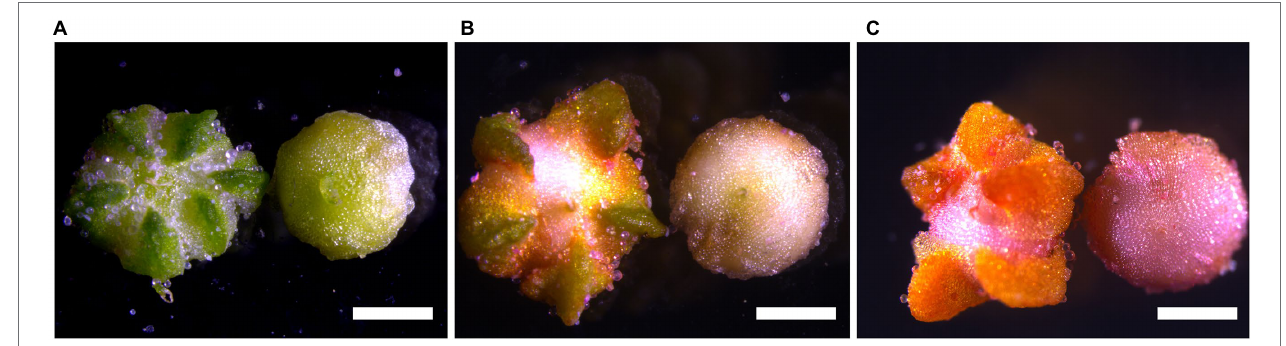
FIGURE 1 | Microscopy photos of quinoa seeds (Titicaca) at the early (A) , mid (B) , and late (C) developmental stages used in this study. These developmental stages correspond to the following days post anthesis (dpa) for Titicaca: 15 dpa (early), 25 dpa (mid), and 35 dpa (late). Sepals have been removed from seeds on the right in each panel. Scale bars are 1.07